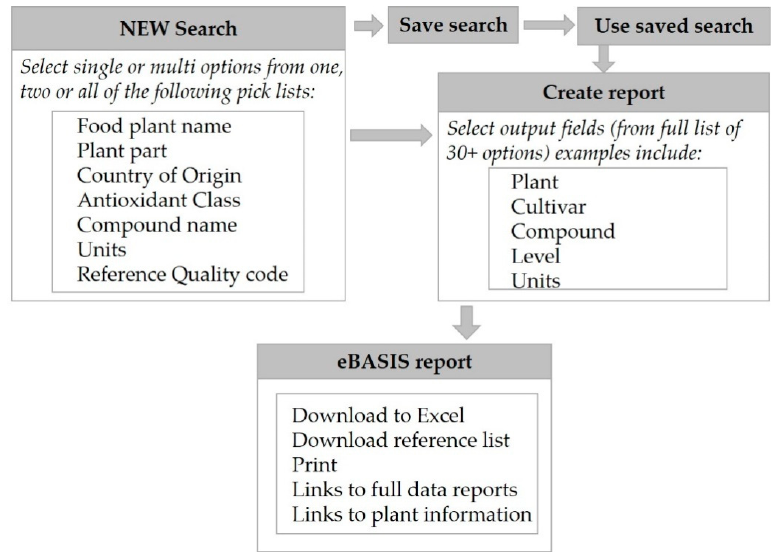
Figure 3. Creation of eBASIS reports.